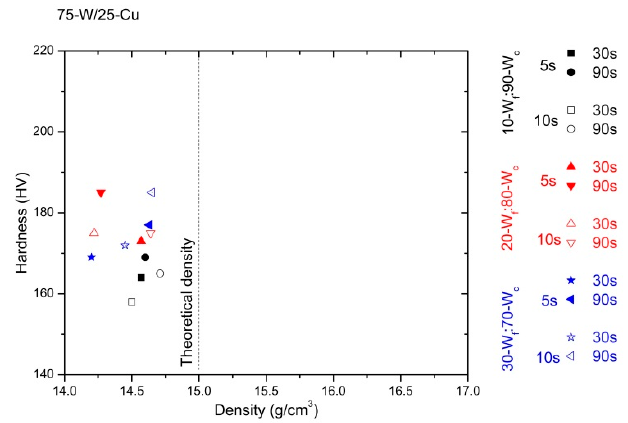
Figure 9. Hardness vs. density of 75-W/25-Cu alloy prepared from three different starting powder mixes and produced under different processing times: degasification times of 5 s and 10 s, in addition to consolidation times of 30 s and 90 s.